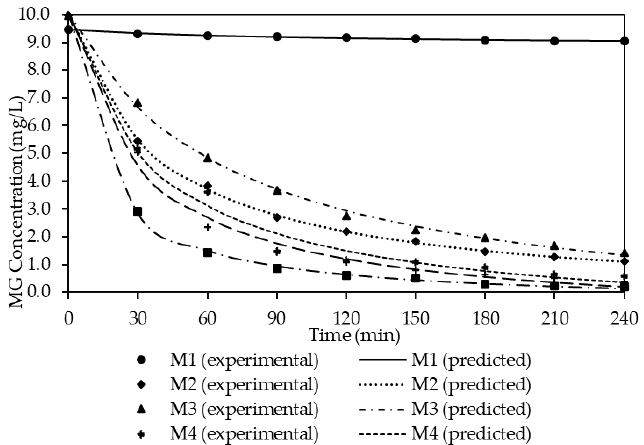
Figure 13. Comparison of the experimental data and simulations from PSO models with different percentages of the carrier, B 2 EHP.